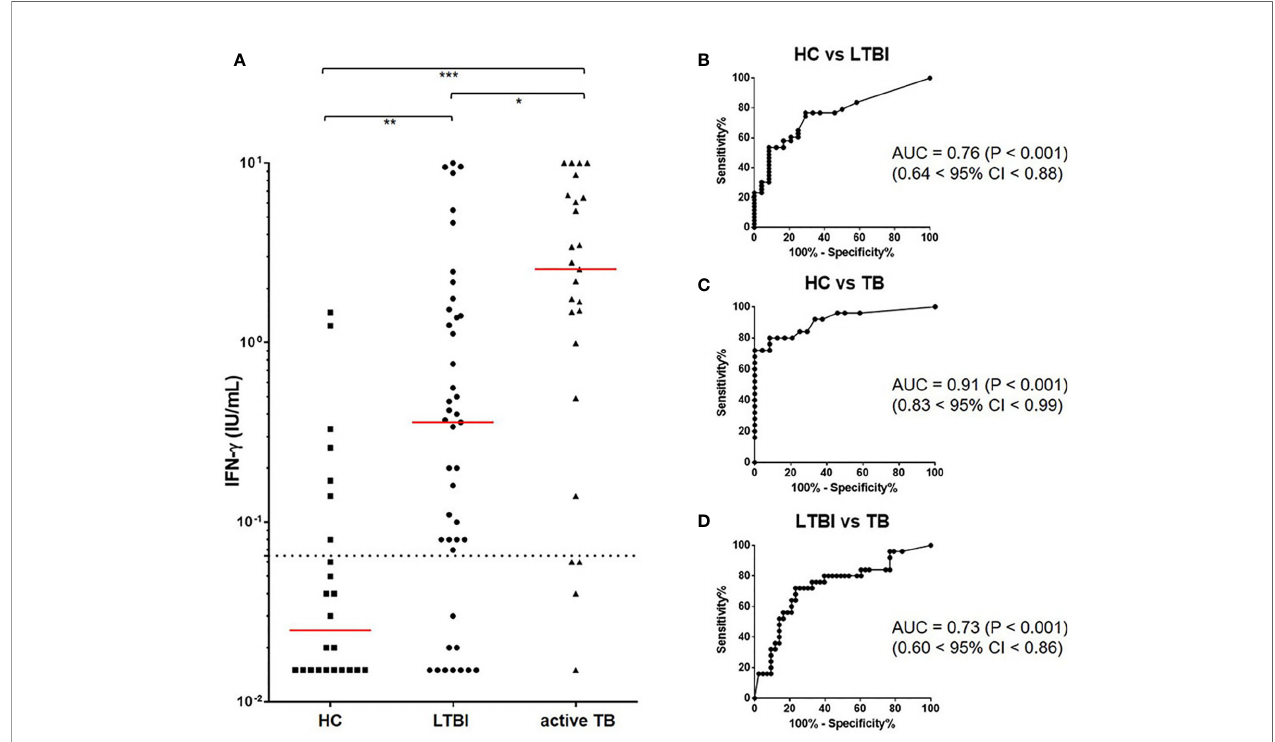
FIGURE 3 | IFN- g responses to the Beijing/K-peptide combination and diagnostic accuracy of identifying M. tb infection. IFN- g responses to MTBK antigen were signi fi cantly higher in active TB and LTBI compared with HC. M. tb infection and disease status were differentiated by IFN- g responses. The median value of IFN- g is marked in red, and a dotted line represents the cut-off for positive results (0.065 IU/mL) (A) . Immune responses to the MTBK antigen had good diagnostic values (AUC > 0.7) for distinguishing between active TB and LTBI (D) , as well as between infected and non-infected individuals (B, C) . *P < 0.05, **P < 0 .01, ***P < 0.001 by one-way ANOVA with subsequent Kruskal-Wallis test, HC, healthy